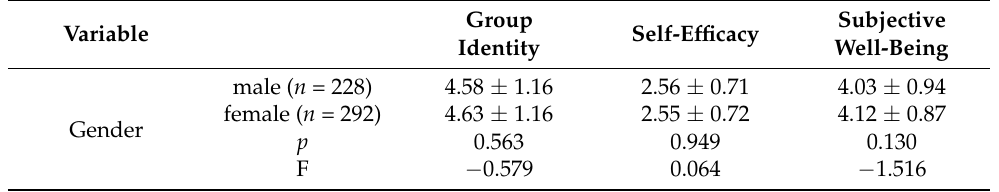
Table 3. Results of the t-tests in different